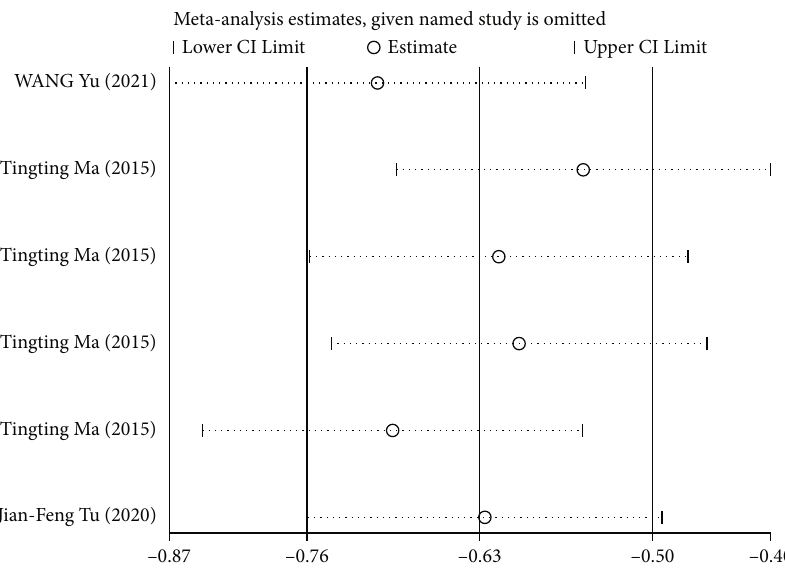
Figure 10: Sensitivity analysis of postprandial